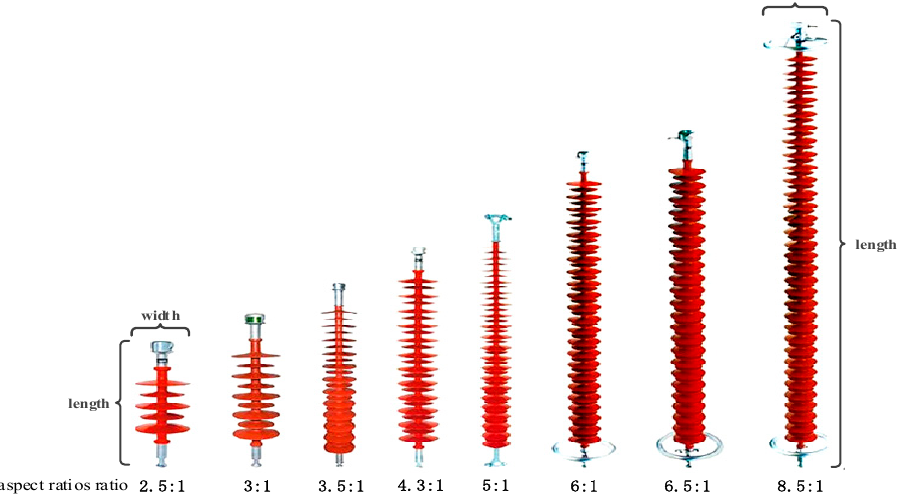
Figure 2. Schematic diagram of insulators with different aspect ratios.